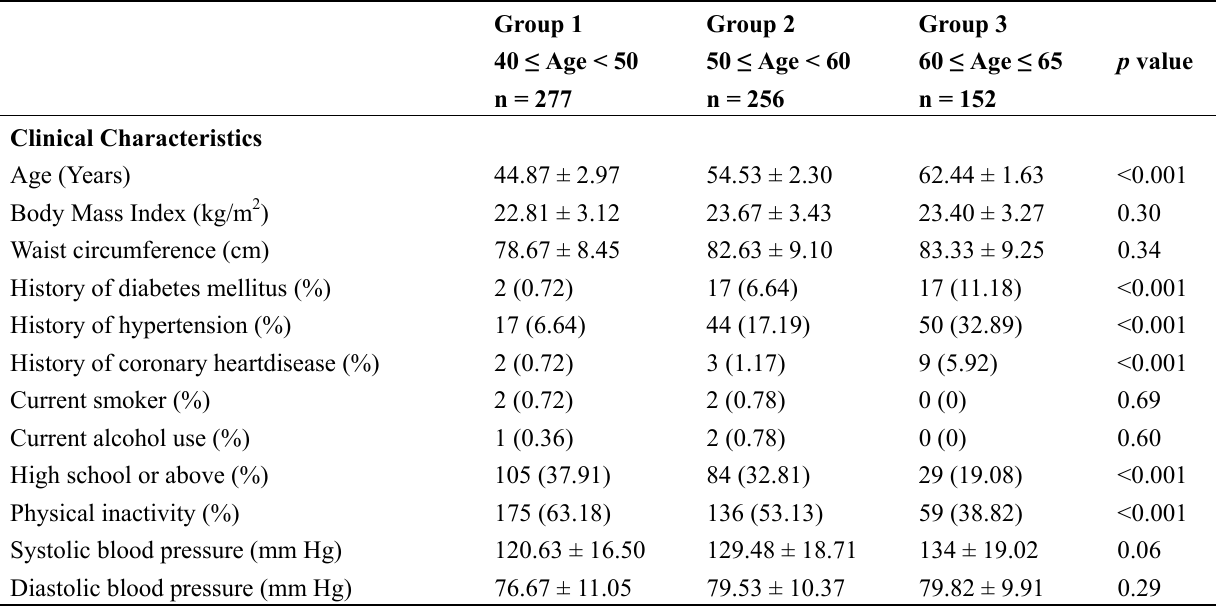
Table 1. Baseline characteristics of perimenopausal